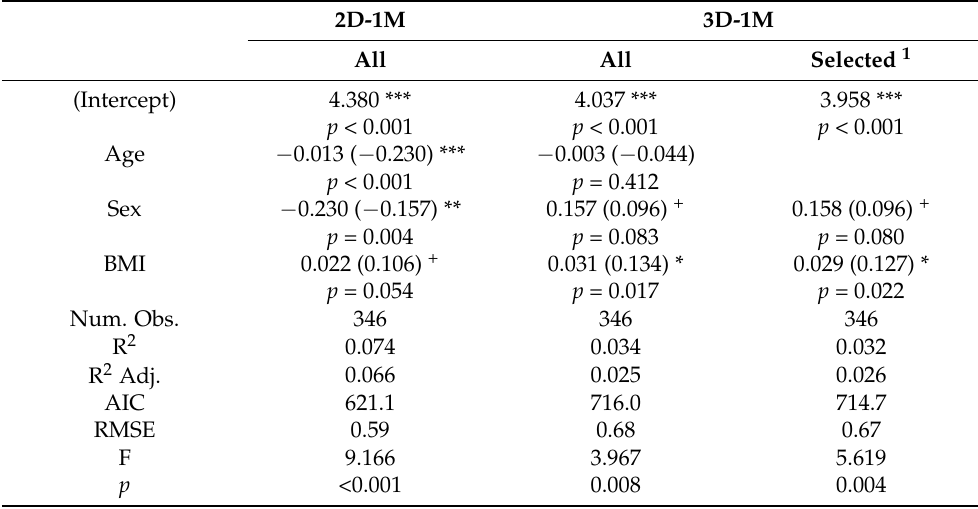
Table 3. Multiple regression analysis of anti-RBD IgG titers (SUM) in 2D-1M and 3D-1M (standard partial regression coefficients are in parentheses). 2D-1M 3D-1M All All Selected 1 (Intercept) 4.380 *** 4.037 *** 3.958 *** p < 0.001 p < 0.001 p < 0.001 Age − 0.013 ( − 0.230) *** − 0.003 ( − 0.044) p < 0.001 p = 0.412 Sex − 0.230 ( − 0.157) ** 0.157 (0.096) + 0.158 (0.096) + p = 0.004 p = 0.083 p = 0.080 BMI 0.022 (0.106) + 0.031 (0.134) * 0.029 (0.127) * p = 0.054 p = 0.017 p = 0.022 Num. Obs. 346 346 346 R 2 0.074 0.034 0.032 R 2 Adj. 0.066 0.025 0.026 AIC 621.1 716.0 714.7 RMSE 0.59 0.68 0.67 F 9.166 3.967 5.619 p <0.001 0.008